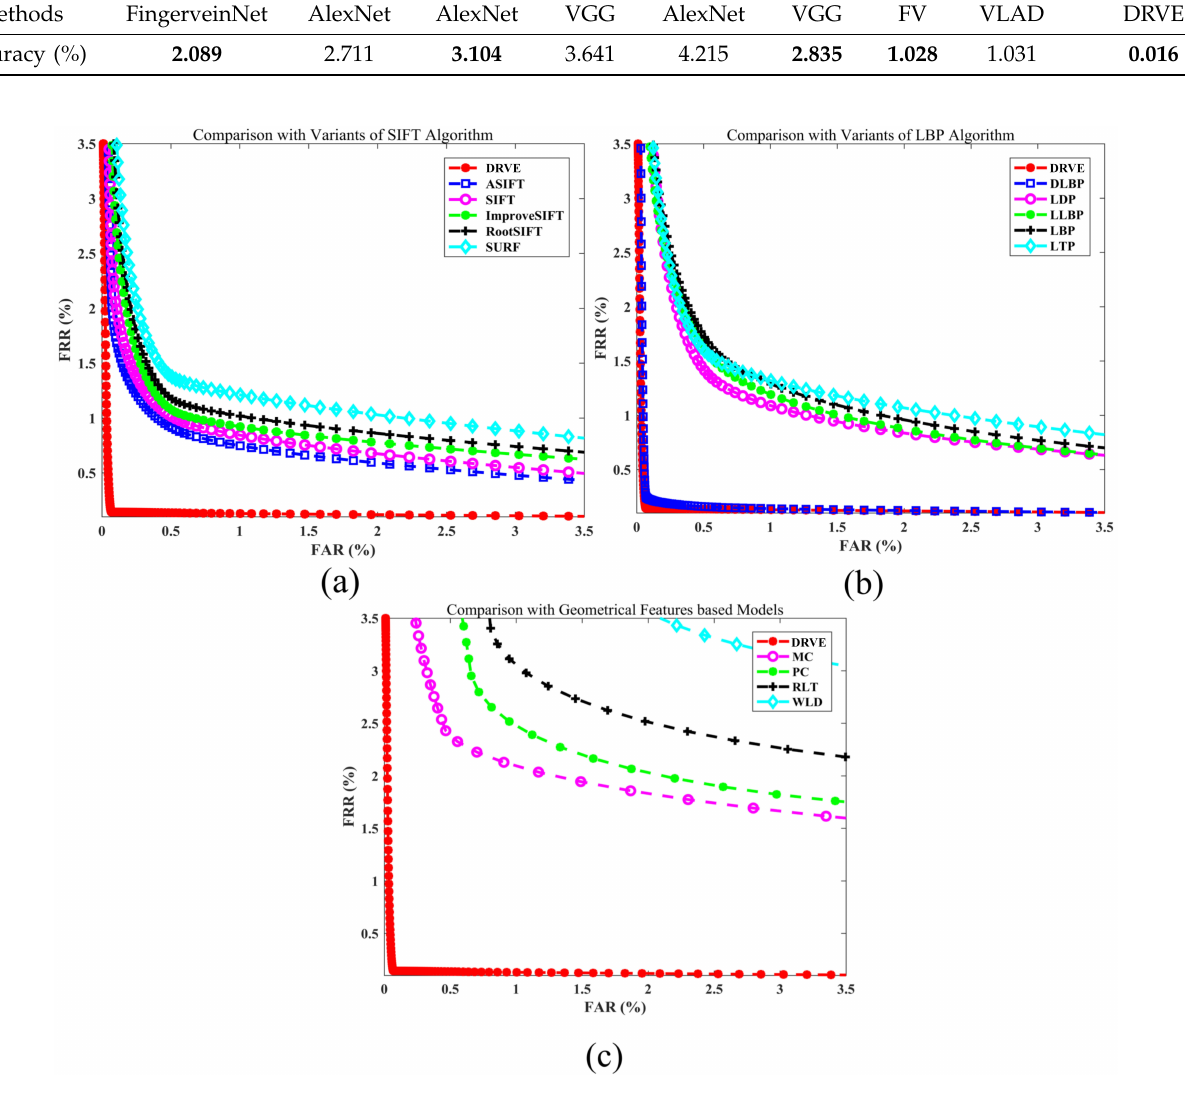
Figure 3. Comparison of ROC curves between the proposed models and representative hand- engineered methods including ( a ) SIFT based models, ( b ) LBP based models, and ( c ) geometrical feature based